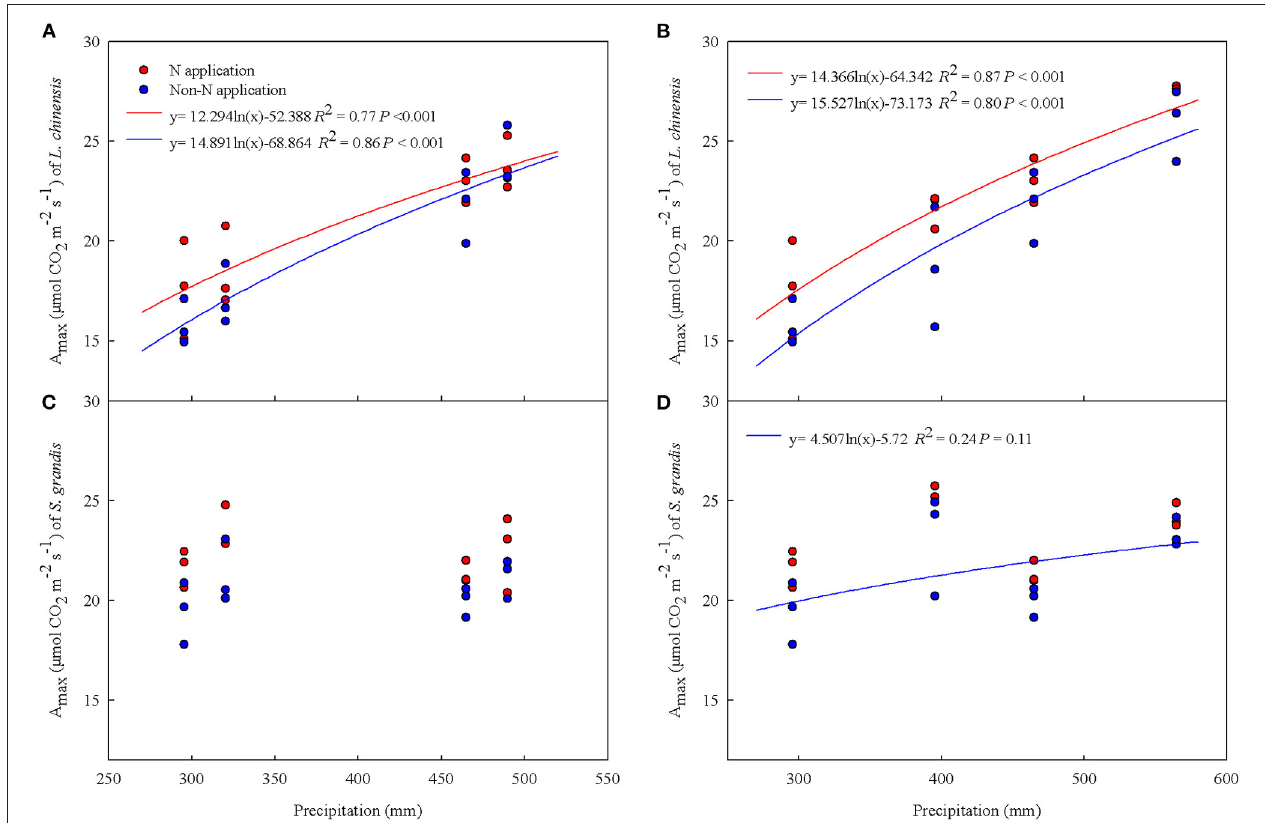
FIGURE 7 | Relationships of the maximum photosynthetic rate (A max ) of Leymus chinensis and Stipa grandis with precipitation (from previous November to October amount) under water addition treatment with N application and non-N application across 2012 and 2013. (A) A max of Leymus chinensis under spring snow addition treatment, (B) A max of Leymus chinensis under summer water addition treatment, (C) A max of Stipa grandis under spring snow addition treatment, and (D) A max of Stipa grandis under summer water addition